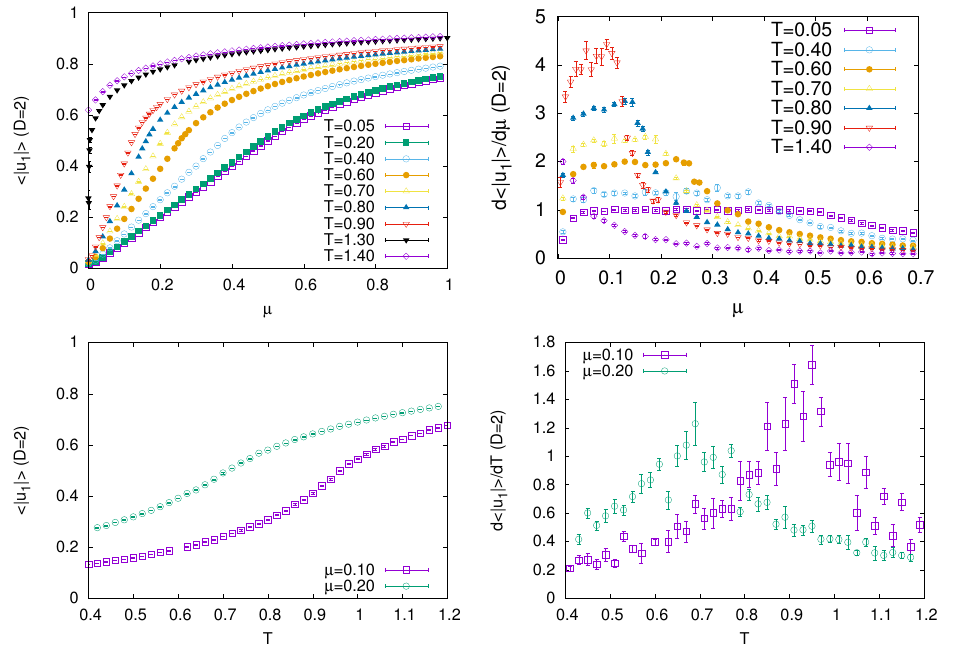
Figure 1 . hj u 1 ji (left) and d hj u 1 ji